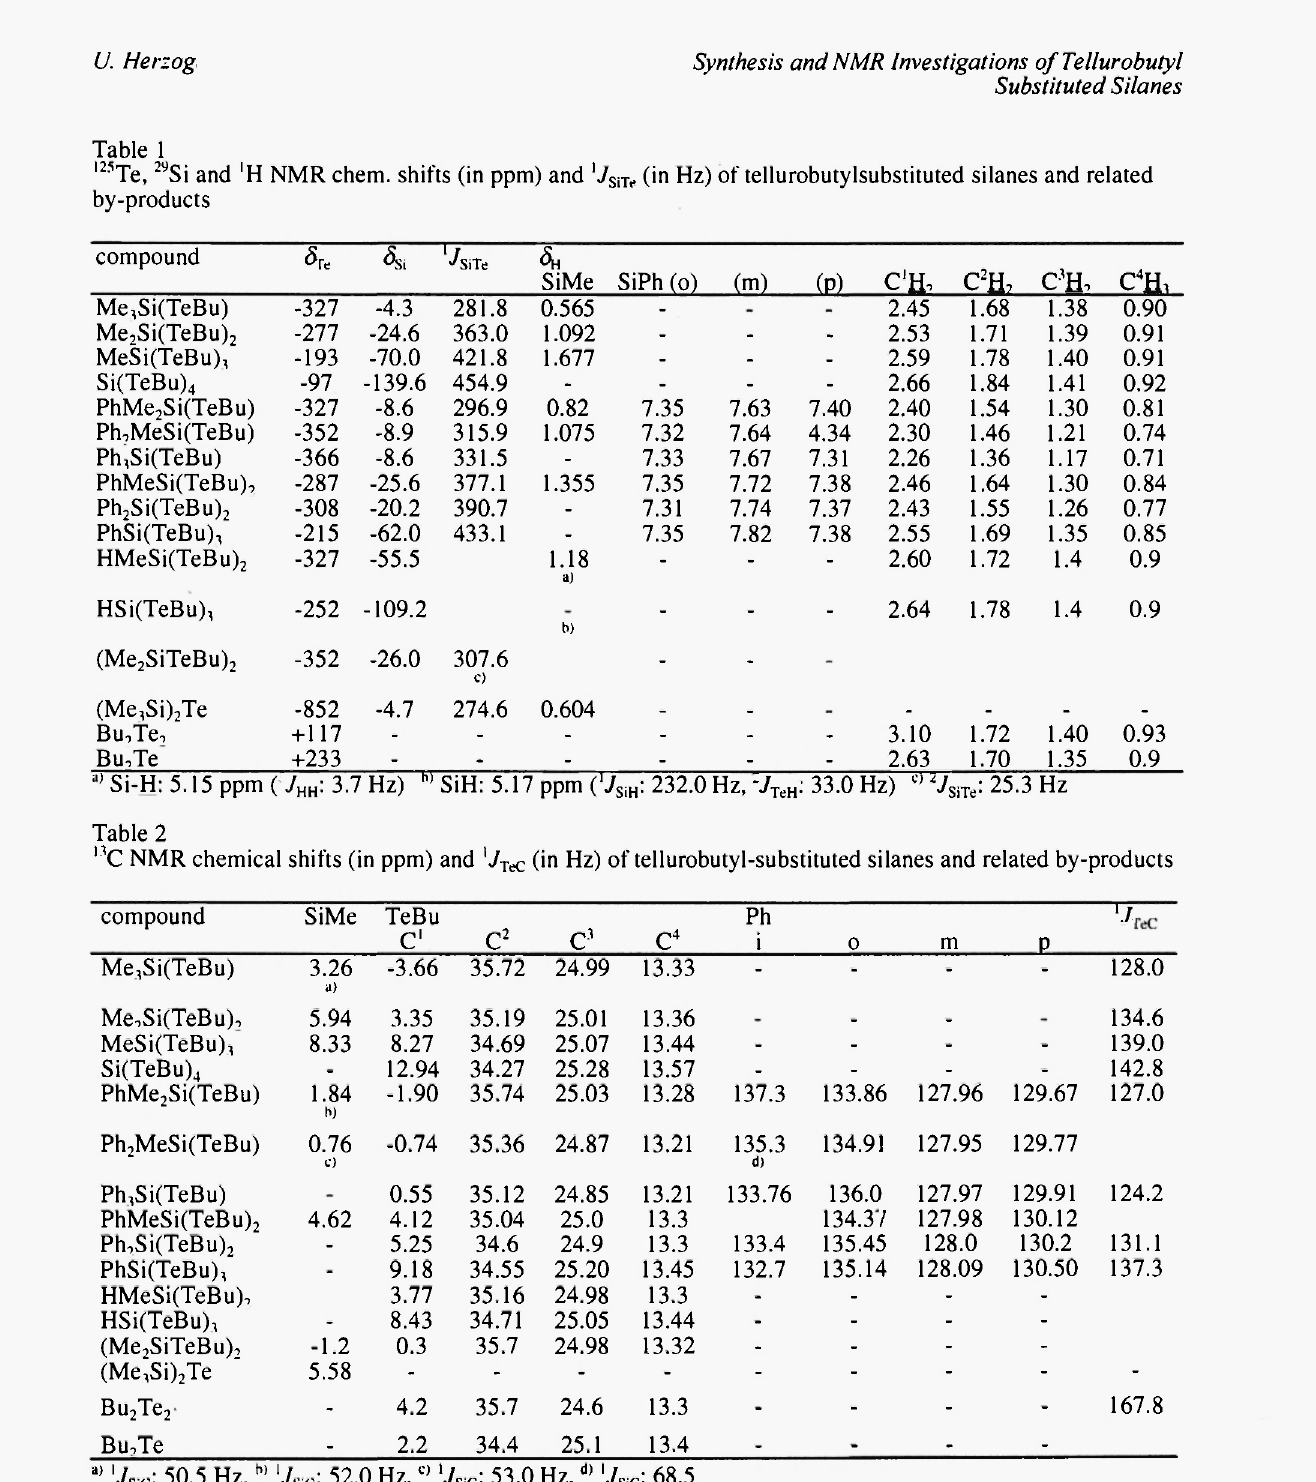
SiTl . (in Hz) of tellurobutylsubstituted silanes and related